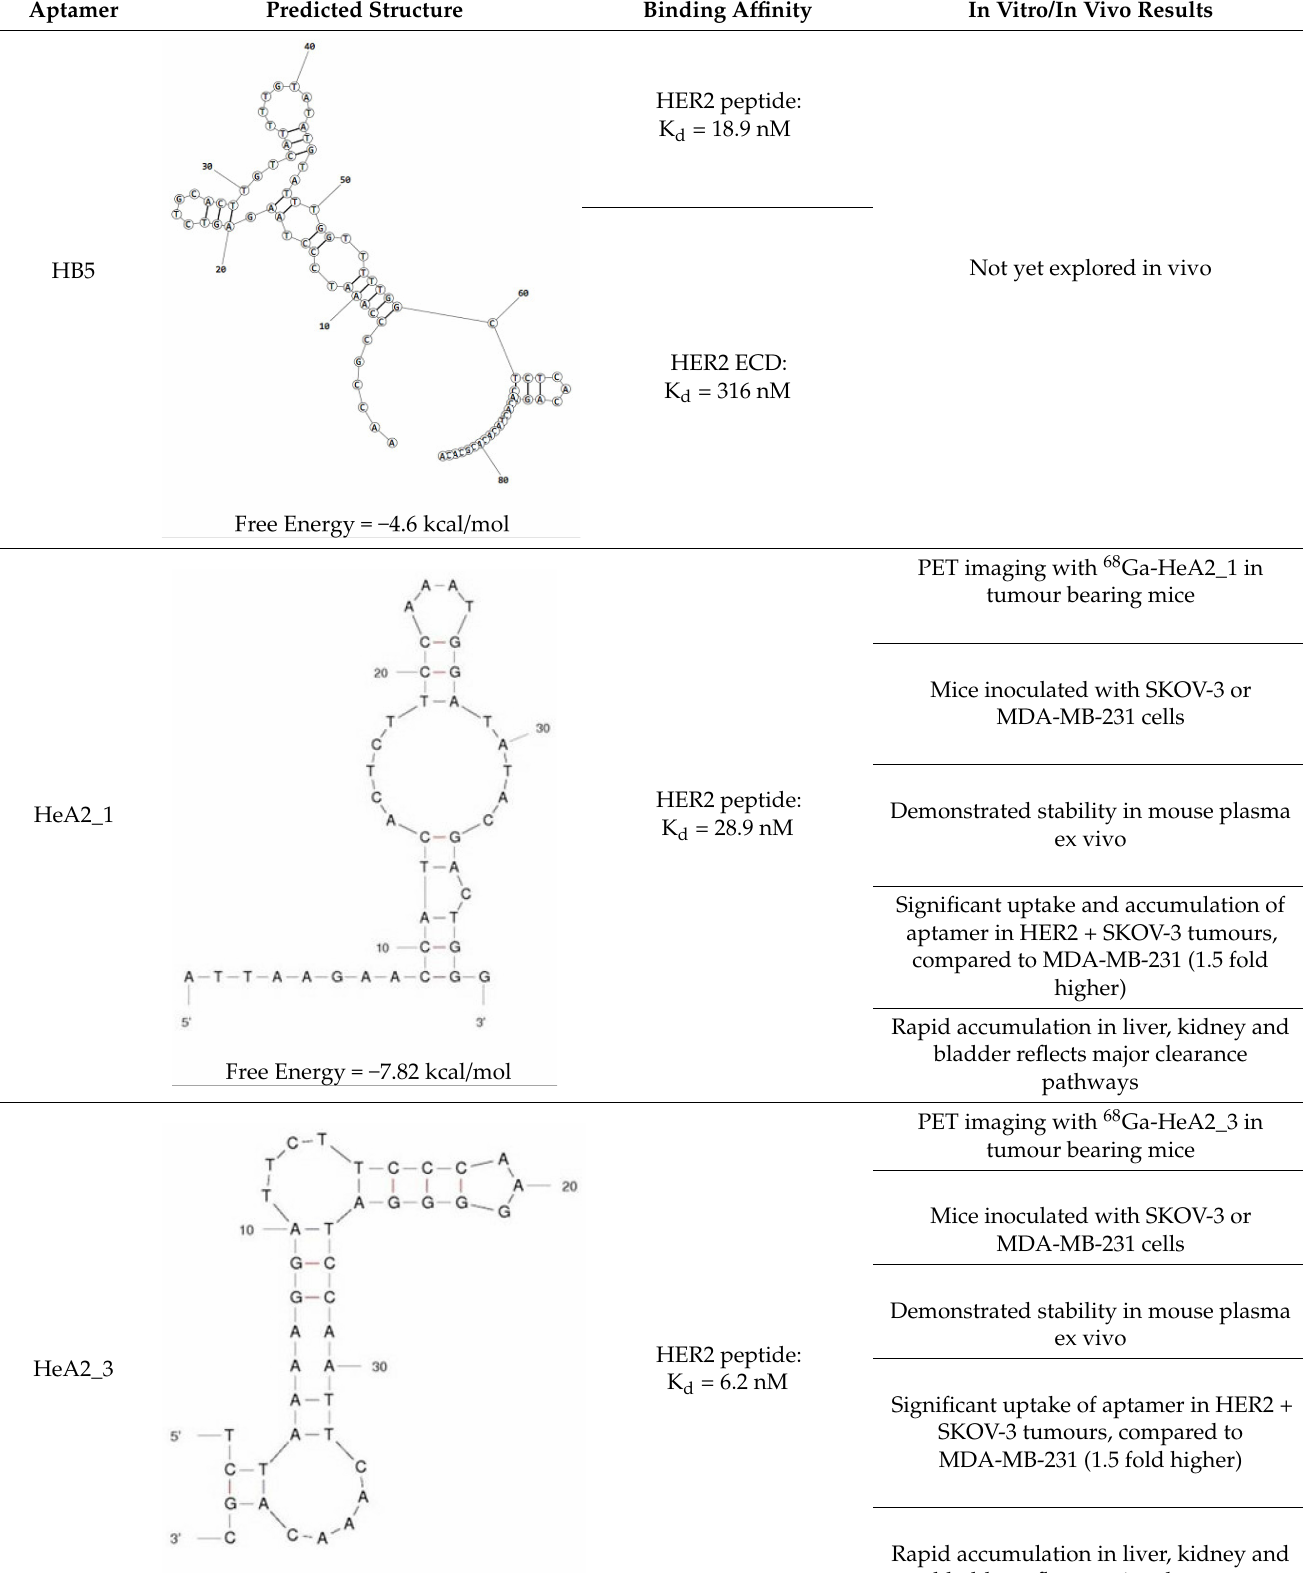
Table 3. Summary of findings of current HER2 aptamers. Adapted from